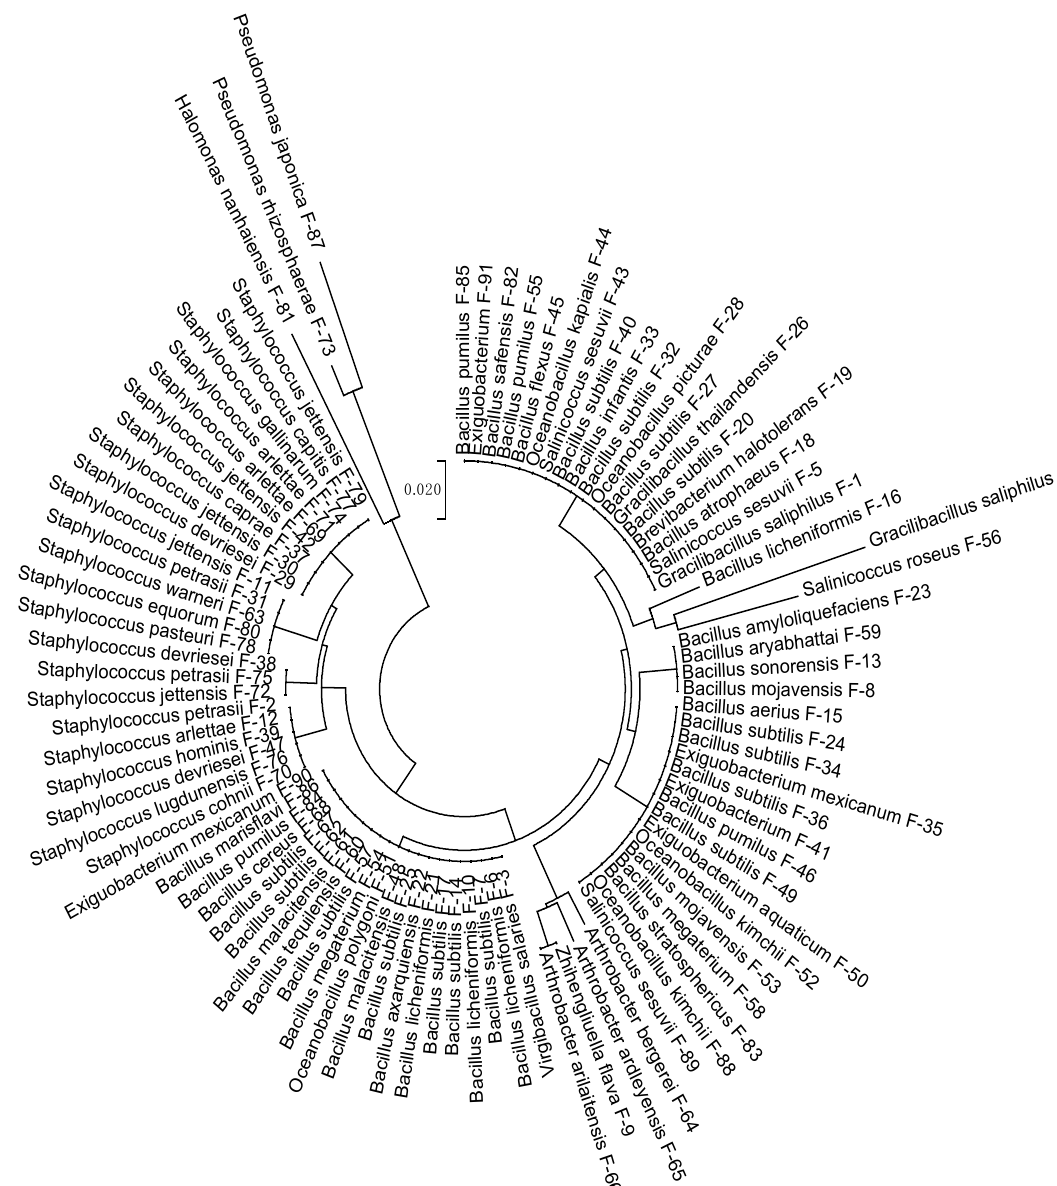
Figure 1. Phylogenetic tree showing the relationships among different halotolerant bacterial strains isolated from rhizosphere and phytoplane of S. fruticosa . (L.) Forssk. Scale bar represents mutations per nucleotide position.